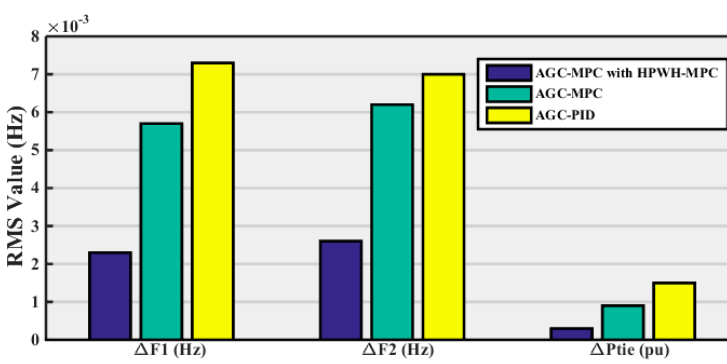
Figure 8. RMS value of deviations for Scenario 1.